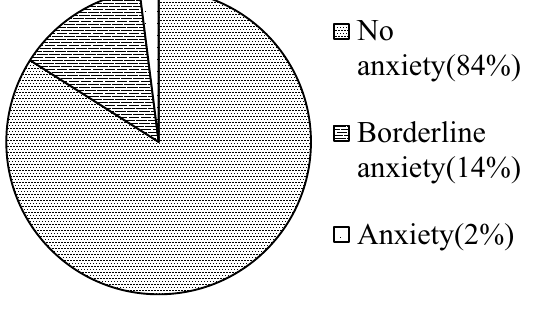
Figure 03. The distribution of anxiety among the study sample Mal-adjustments of sexual life among the study group